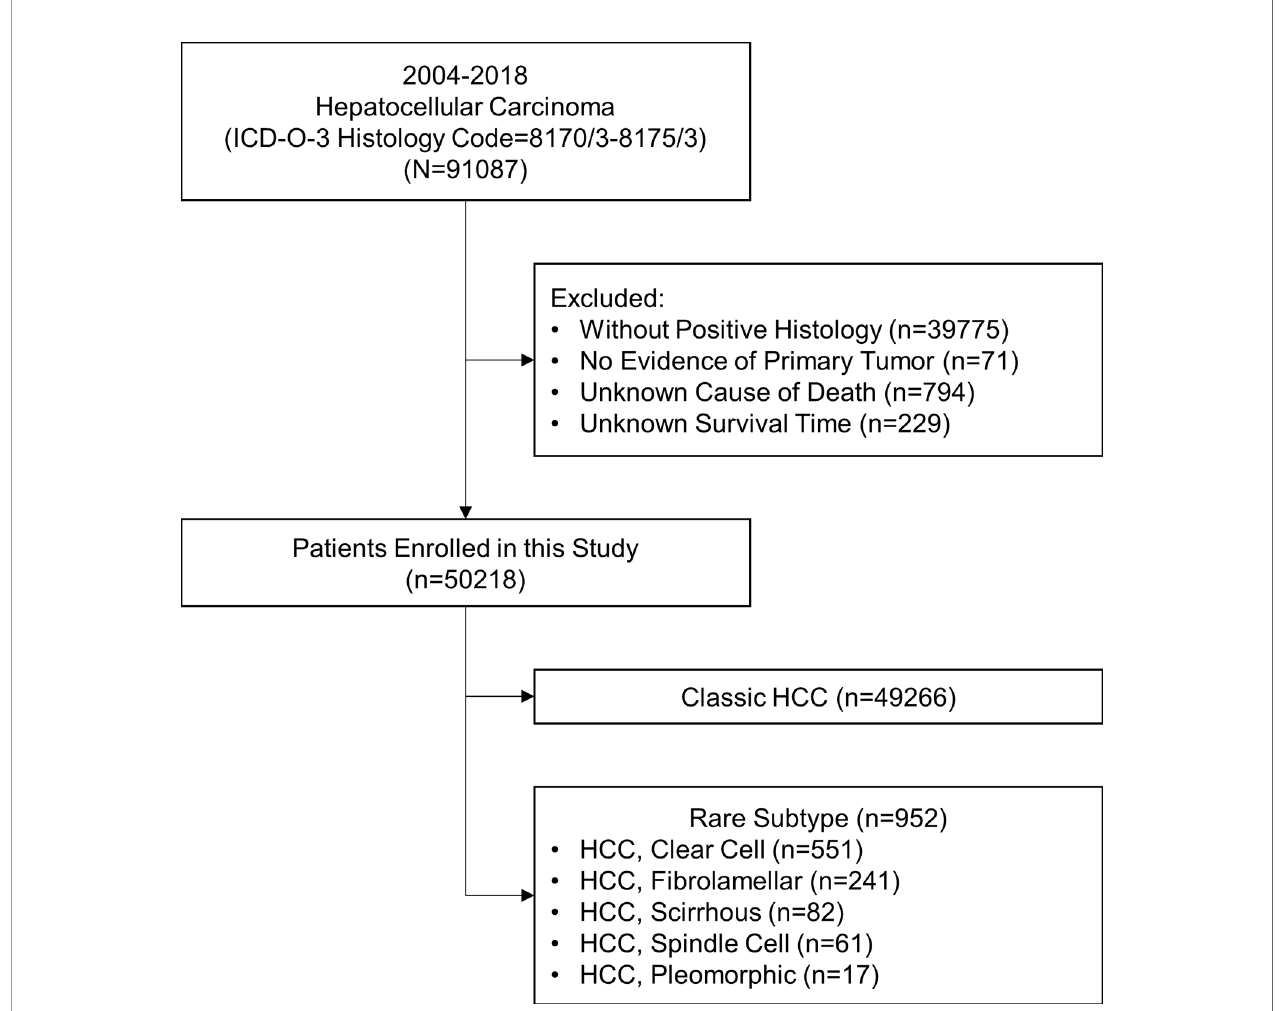
FIGURE 1 | Stepwise extraction process from the Surveillance, Epidemiology, and End Results database. ICD, International Classi fi cation of Diseases; HCC, hepatocellular